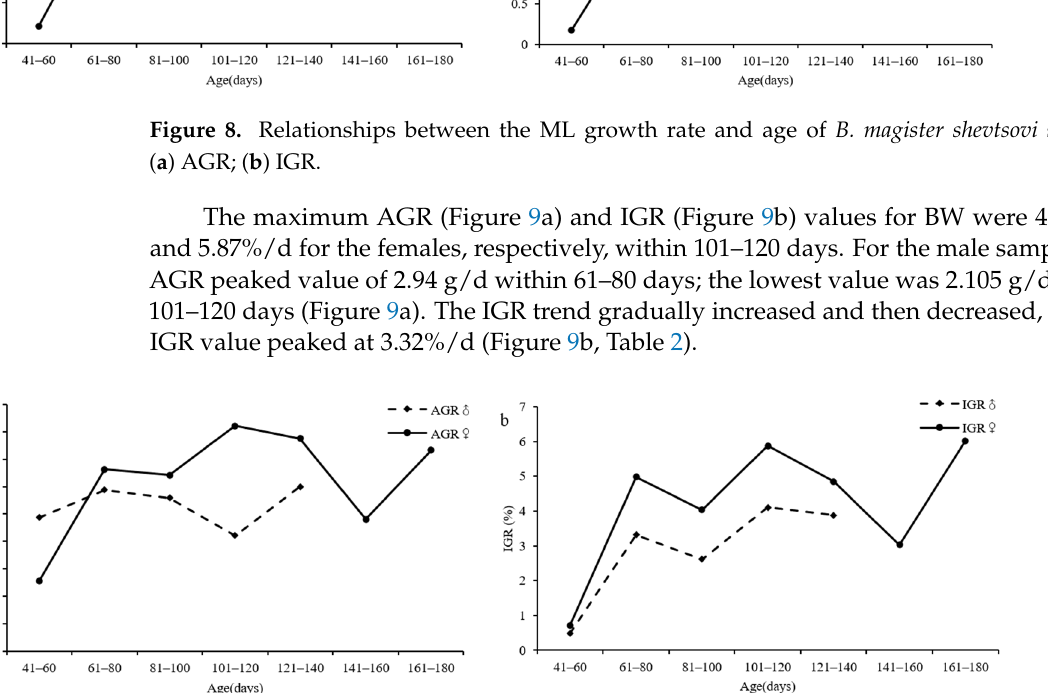
Figure 9. Relationships between the BW growth rate and age of B. magister shevtsovi samples: ( a ) AGR; ( b ) IGR.